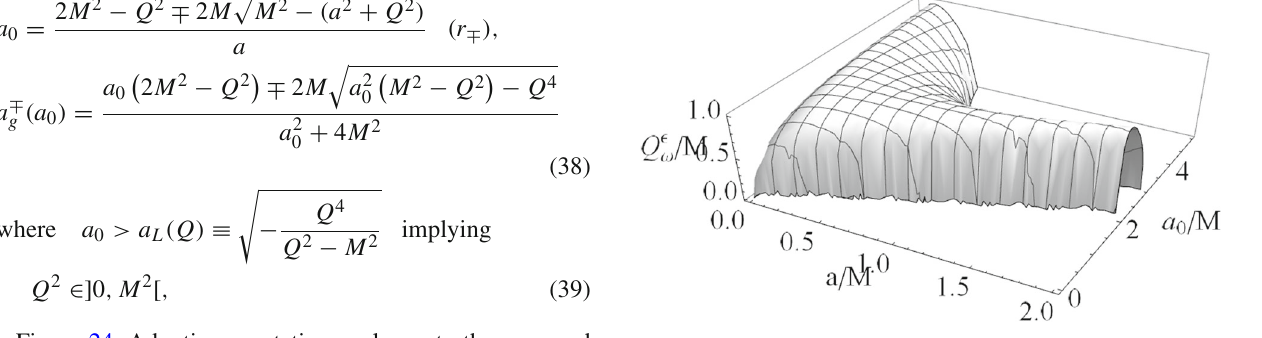
Fig. 22 Charge Q (cid:9) ω , solution of Q ± ω ( r ± (cid:9) ,ω 0 ) = Q defined in Eq.